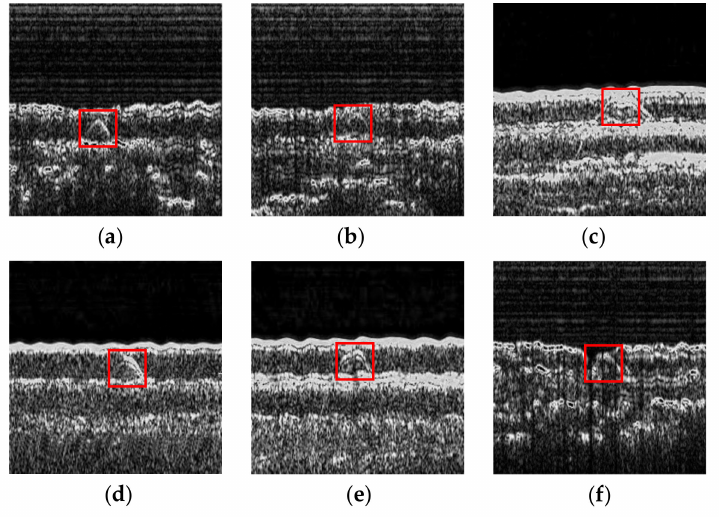
Figure 3. Influence of various factors on pipeline images. ( a – f ) are measured pipeline images disturbed by some common influencing